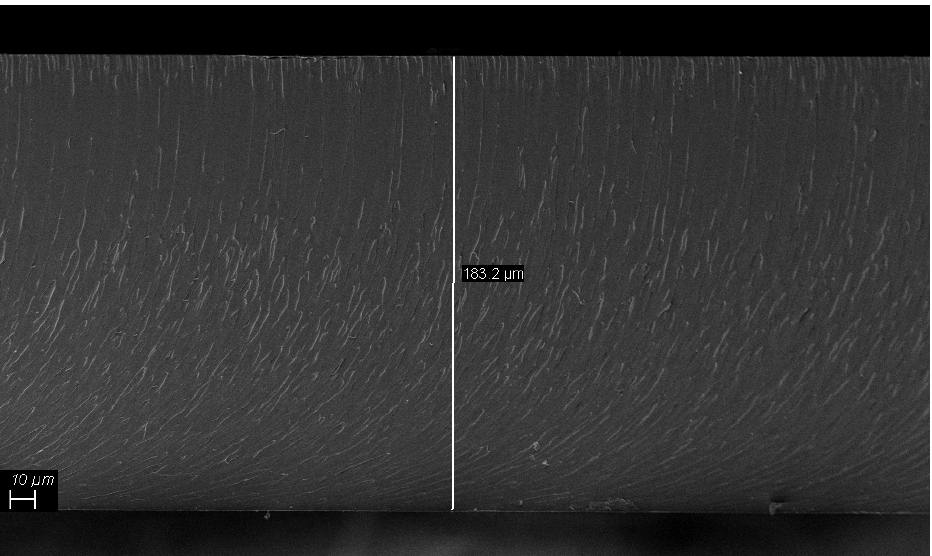
Figure 3. FESEM capture of unfilled UV-LED cured EB150 film on the transversal plane.